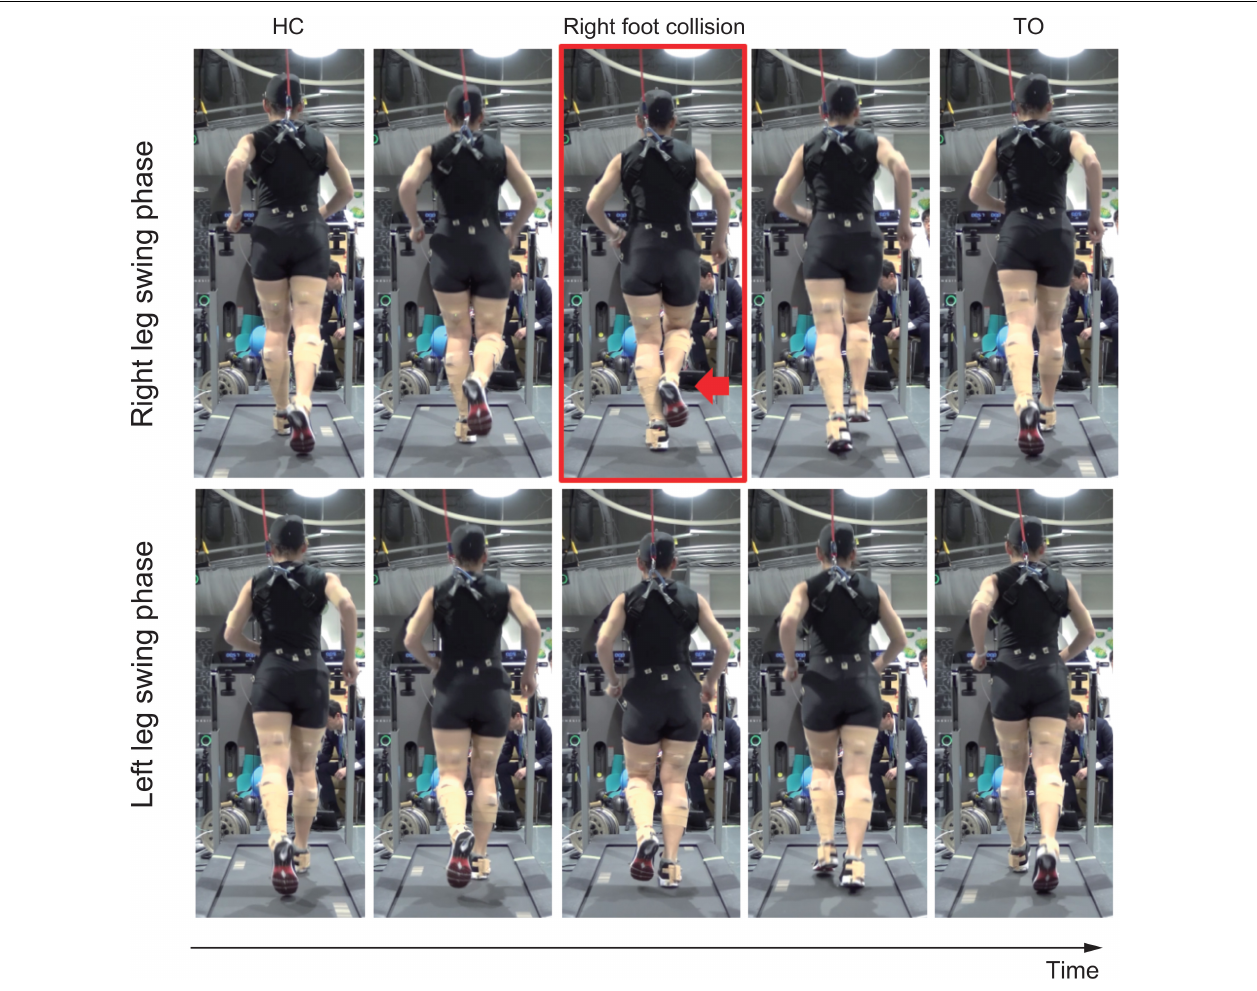
FIGURE 1 | Rear view of the running movement. Upper row shows right leg swing-phase, and lower row shows left leg swing-phase. Red arrow in the red squared panel shows right foot collision with the left calf.